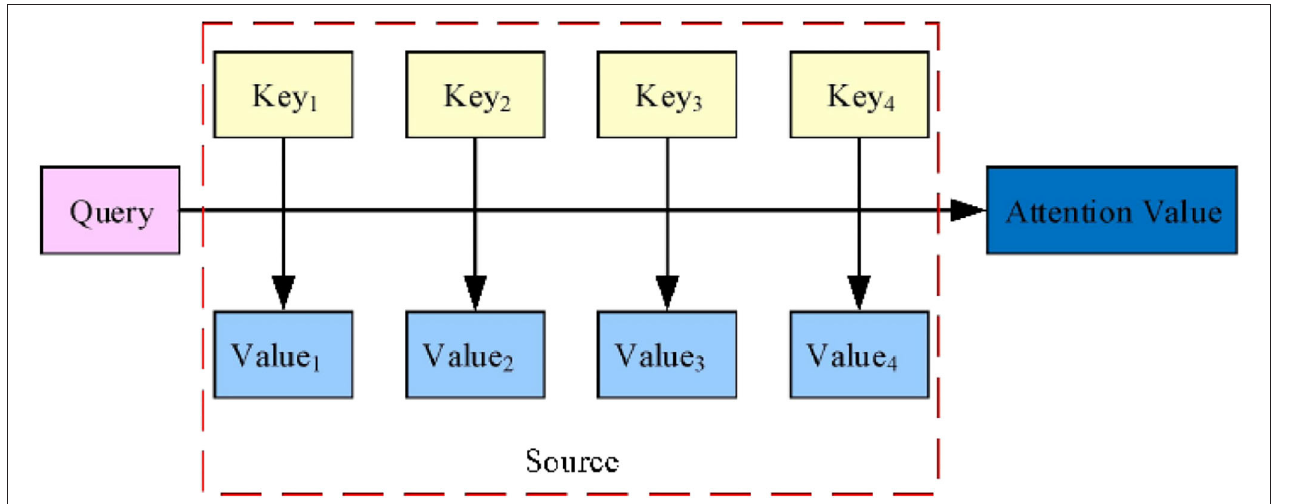
FIGURE 1 | The essence of the attention